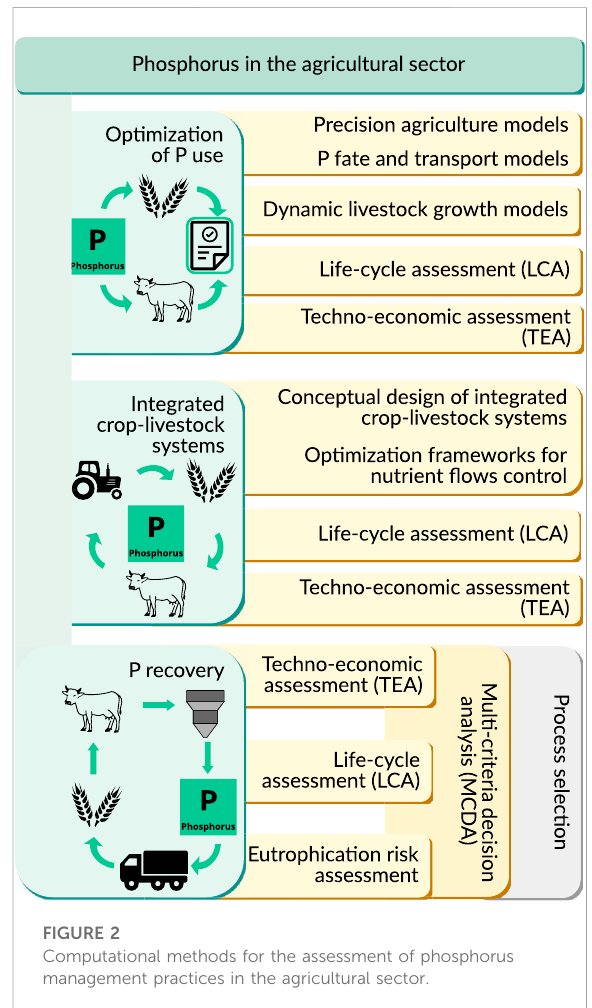
FIGURE 2 Computational methods for the assessment of phosphorus management practices in the agricultural